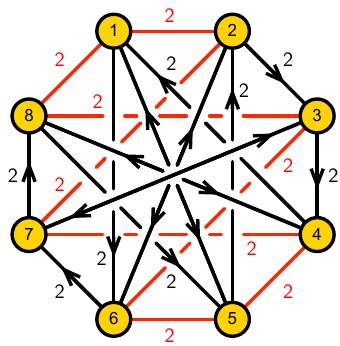
Figure 6 . Quiver for Y 2 , 0 ( CP 1 × CP 1 ) .